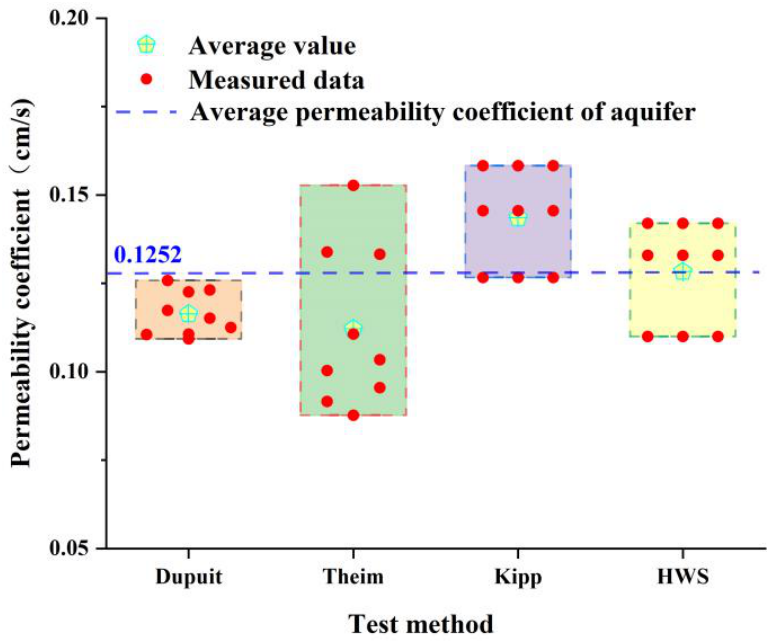
Figure 10. Calculation results of permeability coefficients of aquifer for each analytical method un-